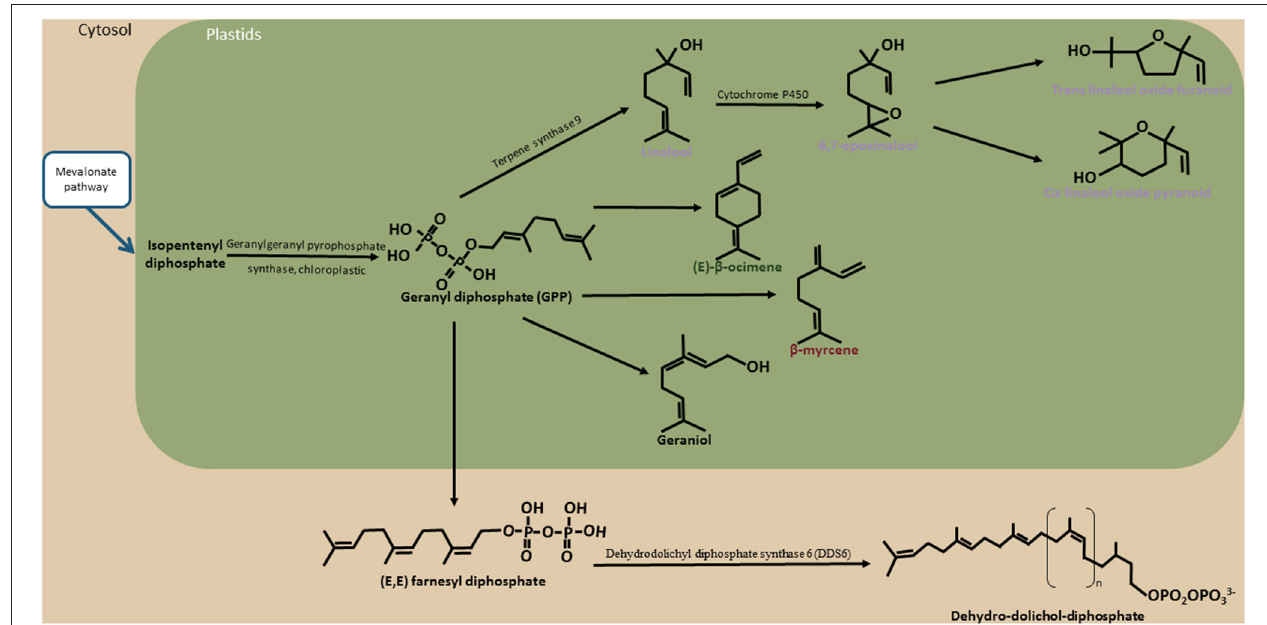
FIGURE 5 | Terpene biosynthesis pathway. The schema illustrates the different biosynthesis pathways of compounds belonging to the terpene biosynthesis pathway identified in cocoa. Compounds known to have a floral taste are noted in purple. The blue arrows represent the bridges between the terpene biosynthesis pathway and mevalonate pathways. The names of these other biosynthetic pathways are framed in blue. The black arrows represent the enzymatic actions. The names of the enzymes are indicated (when identified) around these arrows. In green represented the limit of the plastids. In light brown are represented the limits of cytosol.